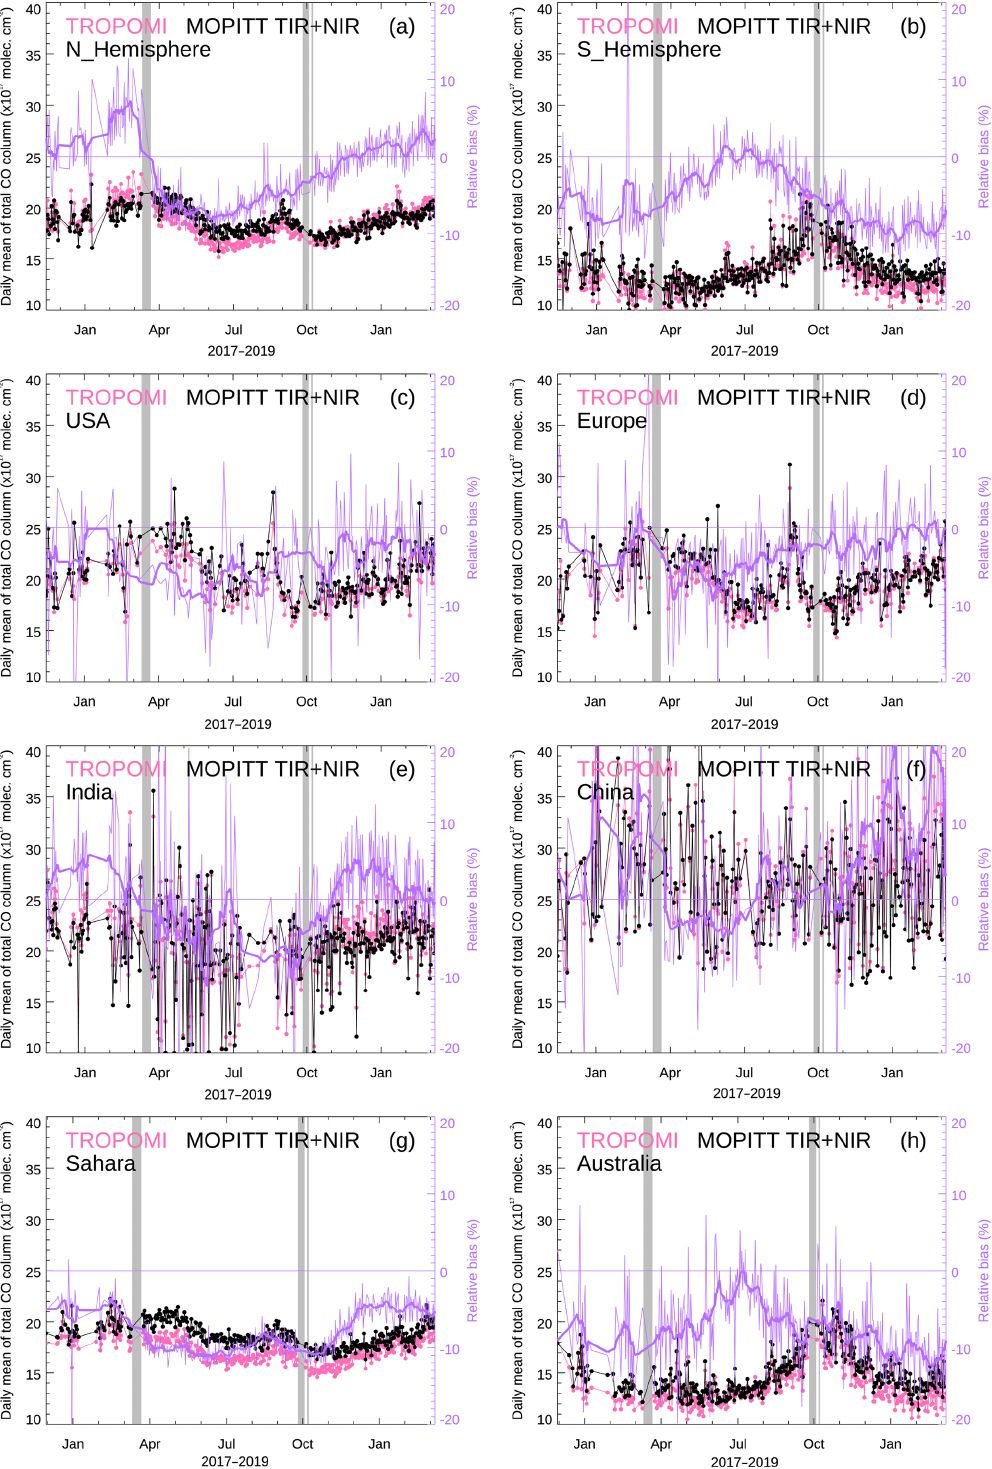
Figure 5. Comparison of colocated land retrievals from TROPOMI (pink) and MOPITT TIR + NIR (black) for each ROI analyzed. See caption to Fig. 3 for